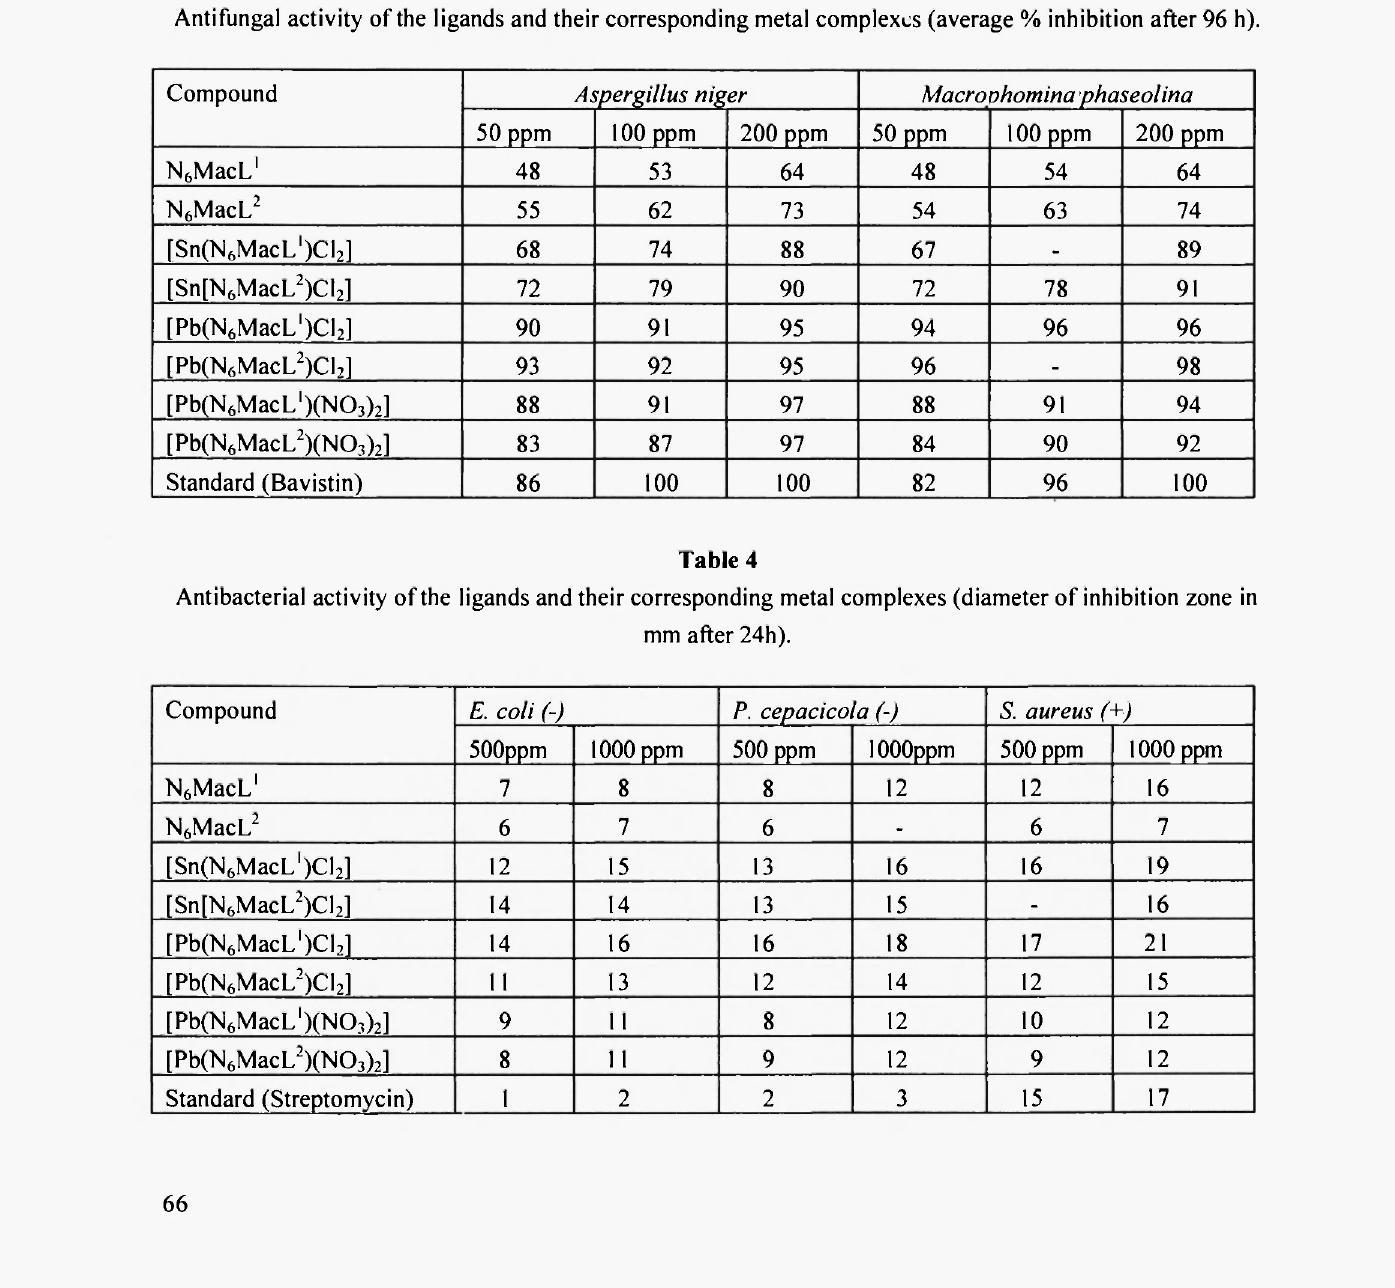
Antifungal activity of the ligands and their corresponding metal complexes (average % inhibition after 96 h). Compound